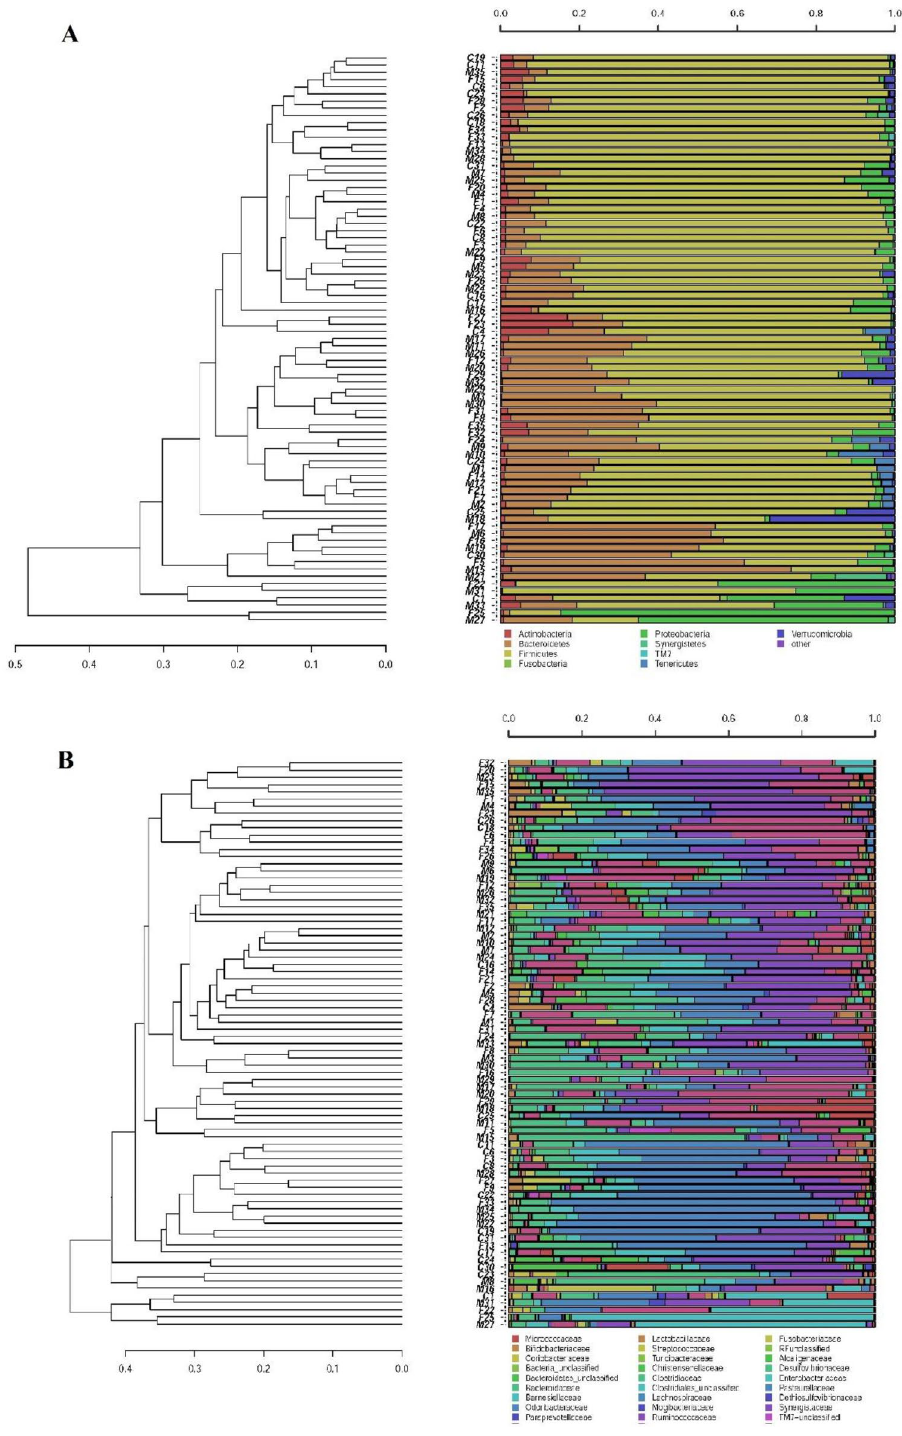
Figure 2. Hierarchical cluster analysis of classified sequences at phylum ( A ) and family ( B ) classification levels. The three experimental groups are indicated as M (CFS patients), F (patients’ relatives), and C (external healthy controls). Bars of different colors indicate the relative percentage of bacterial phyla identified in each fecal sample. Only taxa participating with ≥ 5% in at least one sample are shown, while taxa with lower participations were added to the “other” sequence group. Similar samples were clustered using the average linkage